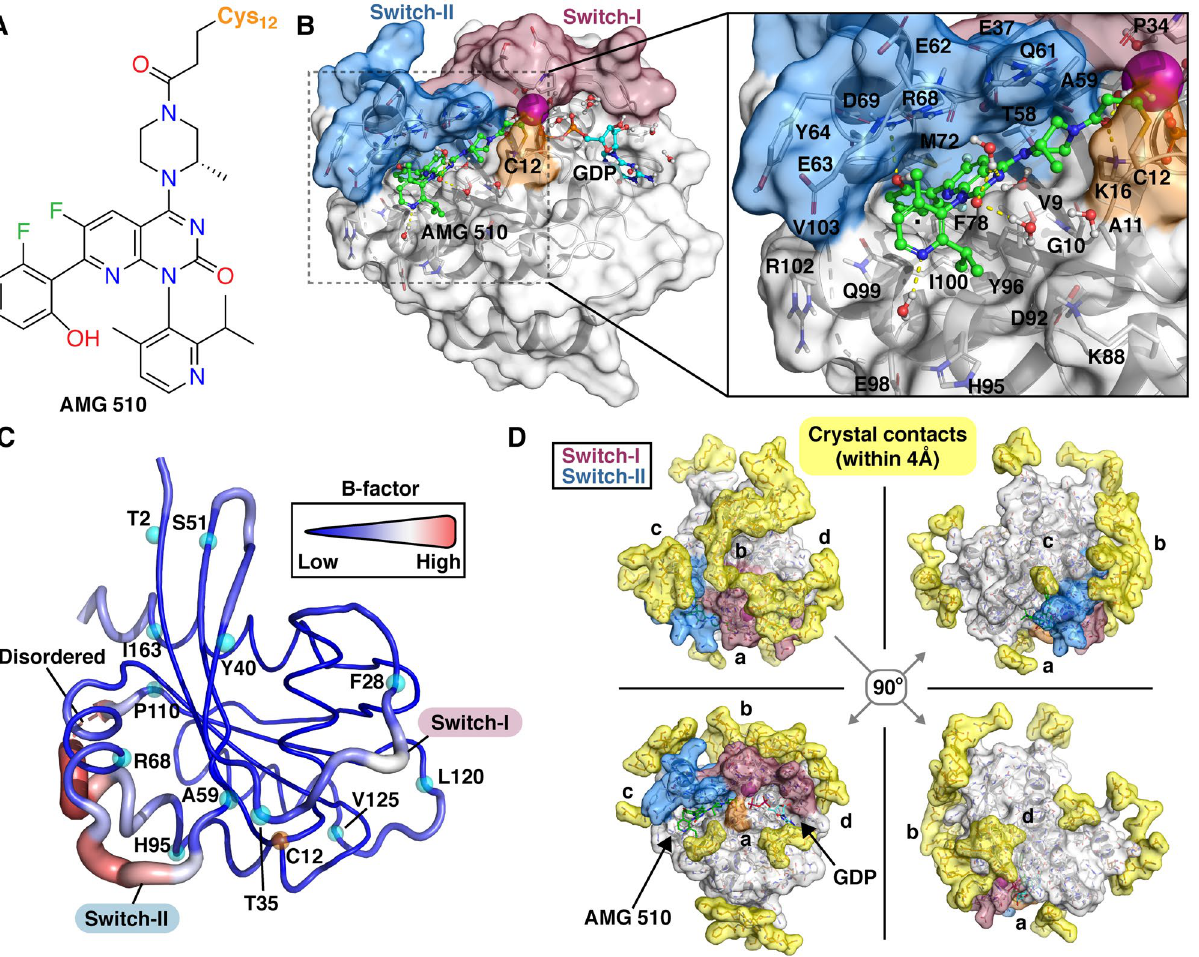
Figure 1. KRAS(G12C)–AMG 510 structure. ( A ) Chemical structure of AMG 510. ( B ) Crystal structure of KRAS(G12C)–AMG 510 complex (PDB ID: 6oim). AMG 510 (green) binds to the SII-P and exploits a cryptic pocket formed by H95/Y96/Q99. ( C ) B -factor values of KRAS(G12C)–AMG 510 structure. Thick and red ribbon indicate a high B -factor value, whereas thin and blue a low value. Cα-atoms of start and end residues of higher B -factor regions are highlighted with cyan spheres (regions: G0–T2; F28–T35; Y40–S51; A59–R68; H95– P110; L120–V125; I163–H166). A disordered region of the structure, D105–E107, is indicated with dashed red line. ( D ) Observed crystal contacts in KRAS(G12C)–AMG 510 structure. Residues within 4 Å of the protein are shown in sticks together with their molecular surface (yellow). In ( B , D ) KRAS switch regions: switch-I: residues 25–40 and switch-II: residues 58–72 are highlighted with red and blue, respectively. C12 is highlighted with